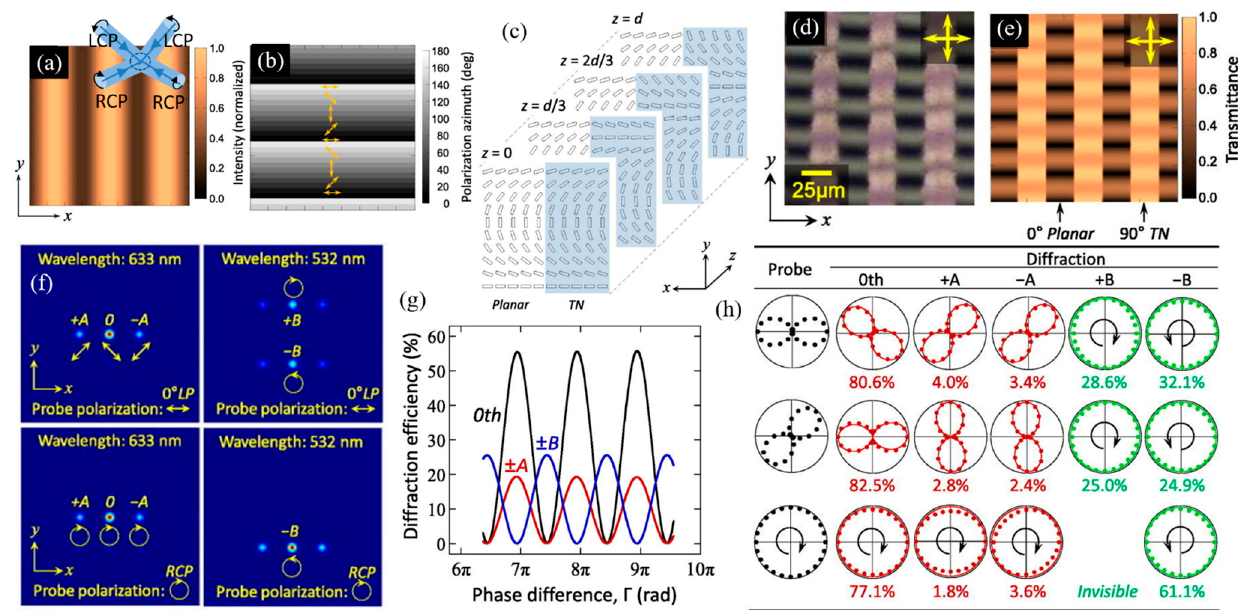
Figure 6. ( a ) Simulated intensity and ( b ) polarization state of the interference field. Inset: Arrangement and polarization configurations of the four interference beams. ( c ) Cross-section view of the LC director distribution in the dimensions of Λ * Λ *d. ( d ) Experimental and ( e ) simulated LC texture observed by POM. ( f ) Simulated diffraction pattern for LP (top) and RCP incident light (bottom) and for different incident wavelengths (phase retardation). ( g ) Calculated diffraction efficiency as a function of the phase retardation. ( h ) Polar plots of the light polarizations. Lines: Simulation results; Scattered dots: Experiment results. Reproduced from Reference [39] with permission from AIP Publishing.